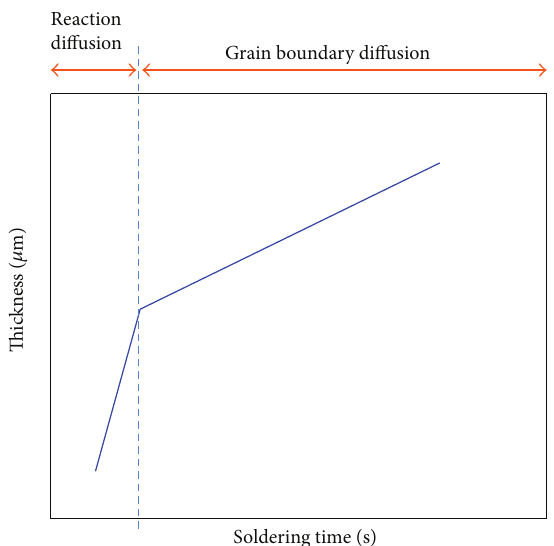
Figure 10: Growth mechanisms of IMC layer during soldering